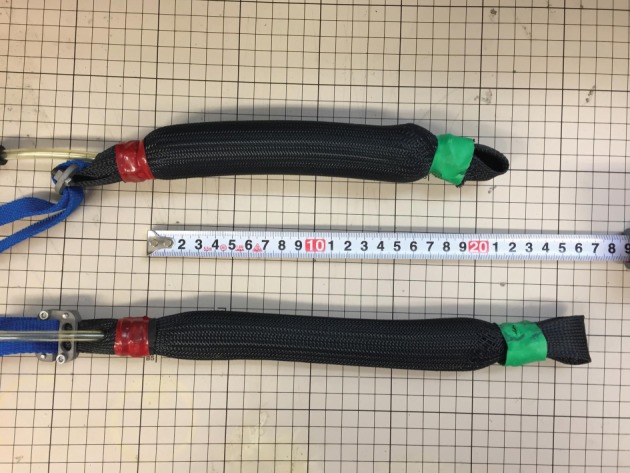
PAMs used in the robot. The upper PAM is supplied with compressed air and the lower PAM is relaxed. The contraction is around 20%. (Online version in colour.)